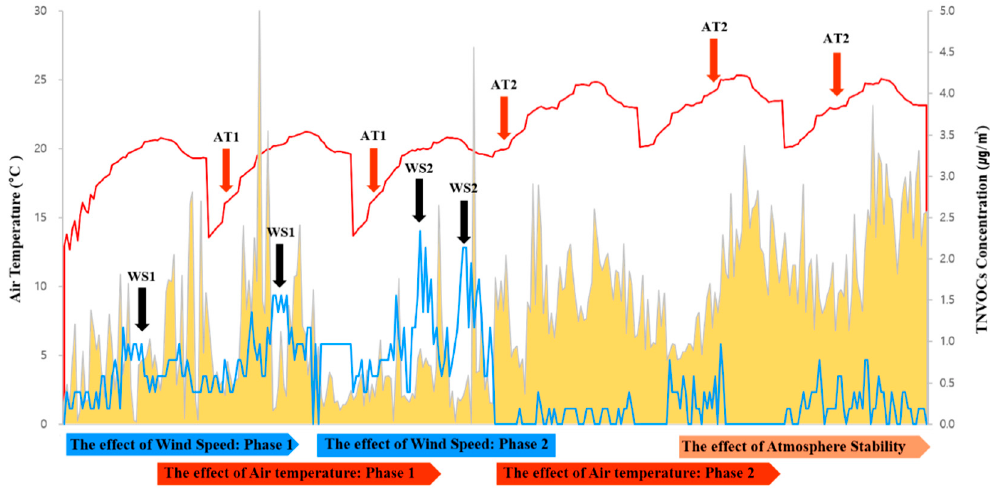
Figure 5. Concentration effect of NVOC by the influence of wind speed and air temperature.